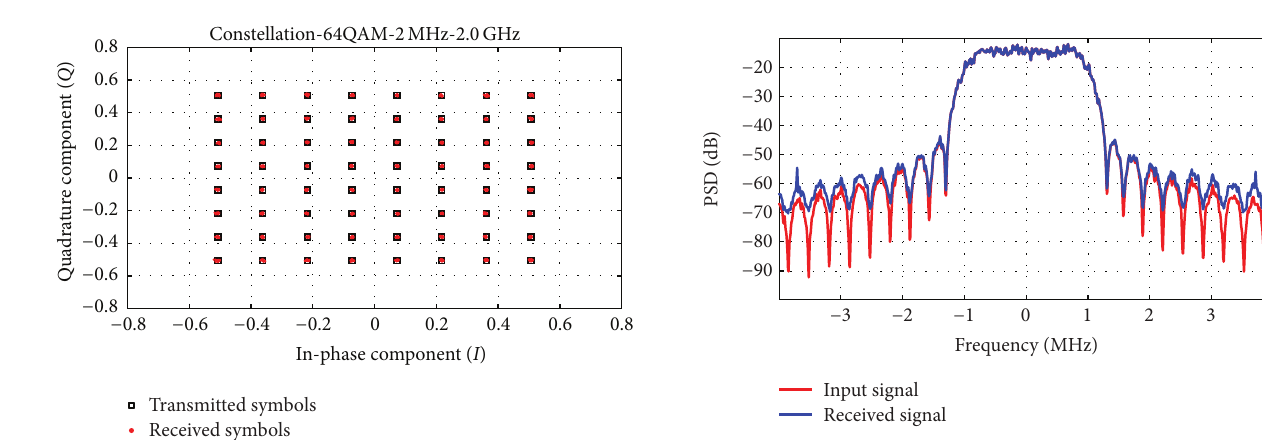
Figure 7: Transmitted and received constellation points of a 64- QAM signal having 2MHz bandwidth for six-port-based receiver (SPR).